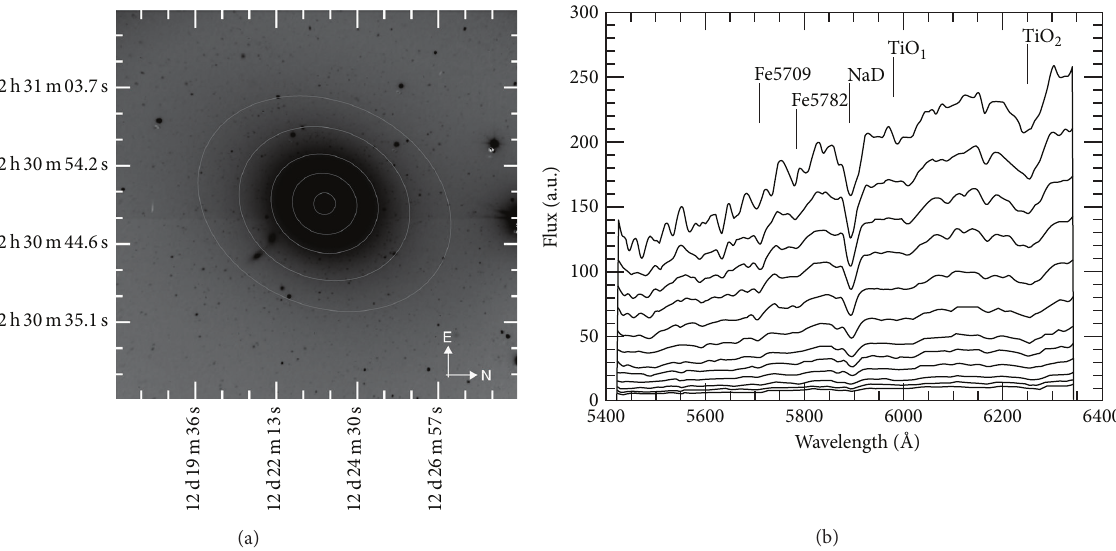
Figure 12: (a) Deep panchromatic V-band image of M87 extracted from the data cube showing some isophotes used to extract spectra. (b) Deredshifted radial spectra of M87. From top to bottom, log 𝑟 (arcsec) = 0.79, 0.93, 1.06, 1.17, 1.25, 1.35, 1.46, 1.54, and 1.61.